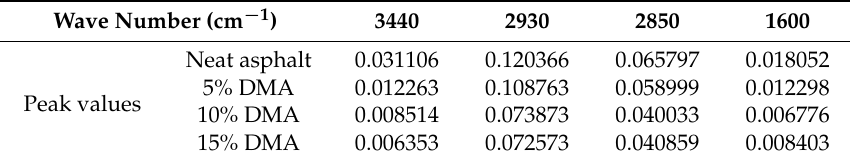
Table 5. Peak values of asphalt spectra.